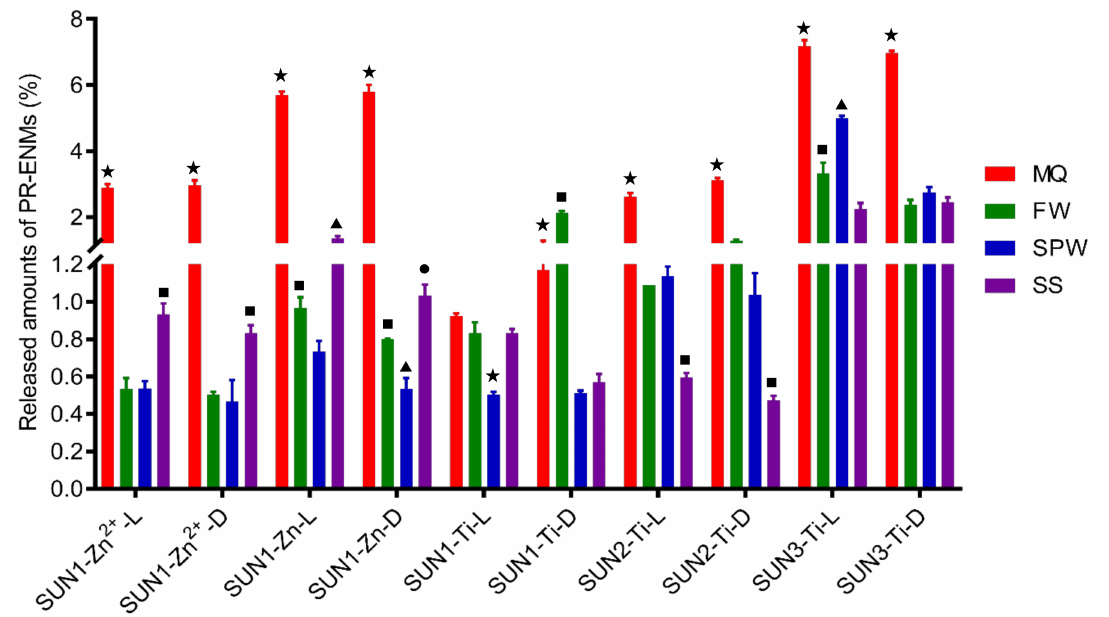
Figure 5. The amount of Zn 2+ , Zn, and Ti released from SUN1–3 in different release media (Milli-Q water (MQ), freshwater (FW), swimming pool water (SPW), and seawater (SS) under light (L) and dark (D) conditions.The differing of symbols ( (cid:70) (cid:4) (cid:78) ) on top of error bars indicates statistical difference ( p < 0.05) between the release media treatments.